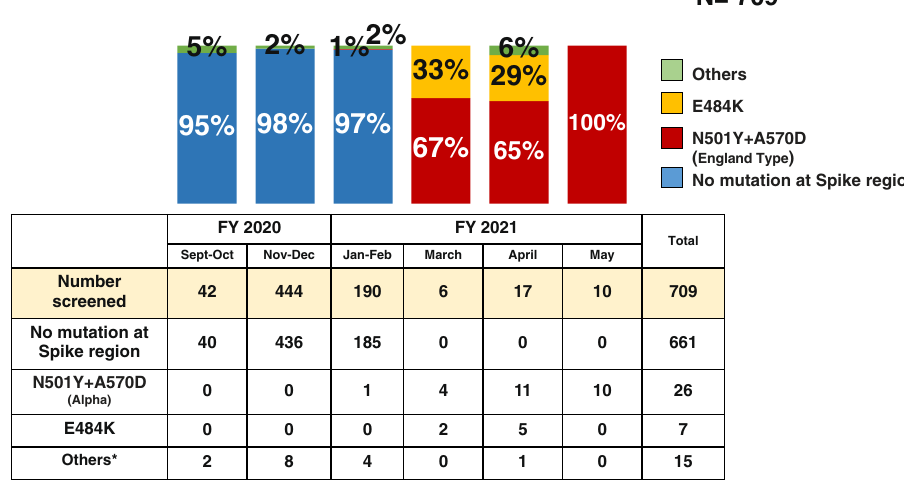
Figure 6. Prevalence of the notable SARS-CoV-2 variants in Hiroshima. The bar graph described the prevalence of B.1.1.7 (Alpha), E484K and the other forms of mutation found in Hiroshima Japan. The red color represents B.1.1.7 (Alpha), the orange color shows E484K mutation, the green color for the other forms of mutation and the blue color for those having no mutation at targeted spike region. The other forms of mutation include single mutations of N501S, I584V, R481K, F515L, P521L, T553S, N606S, A609G, double mutation of K557E and Q613R, and triple mutation of L513F, Q580R and